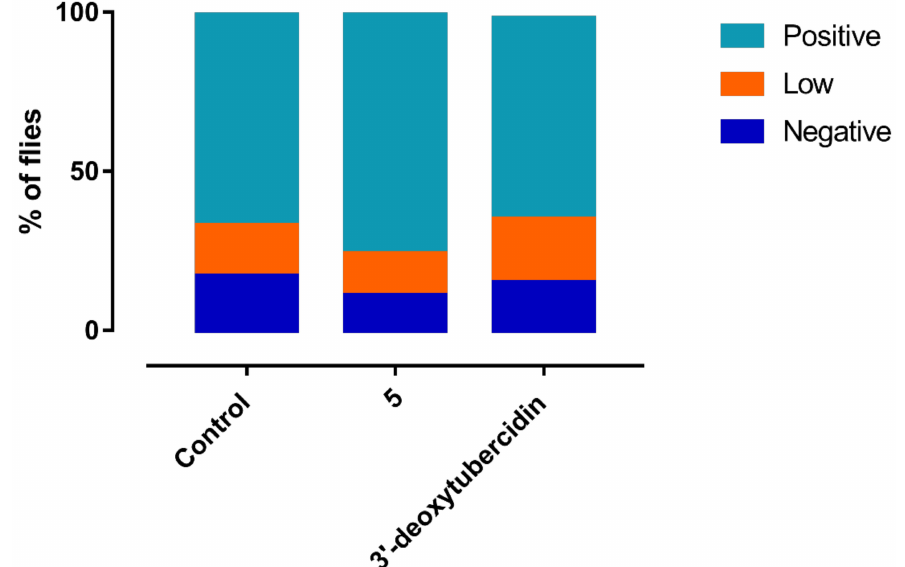
Figure 8. Impact of 5 supplementation on establishment of T. brucei in the tsetse fly midgut. Infectious blood meals were supplemented with 5 or 3 (cid:48) -deoxytubercidin at the IC 50 . Results represent the percentage of G. m. morsitans flies with a negative, low, or positive infection in the midgut and are a representation of two independent experiments with a minimum of 25 flies per